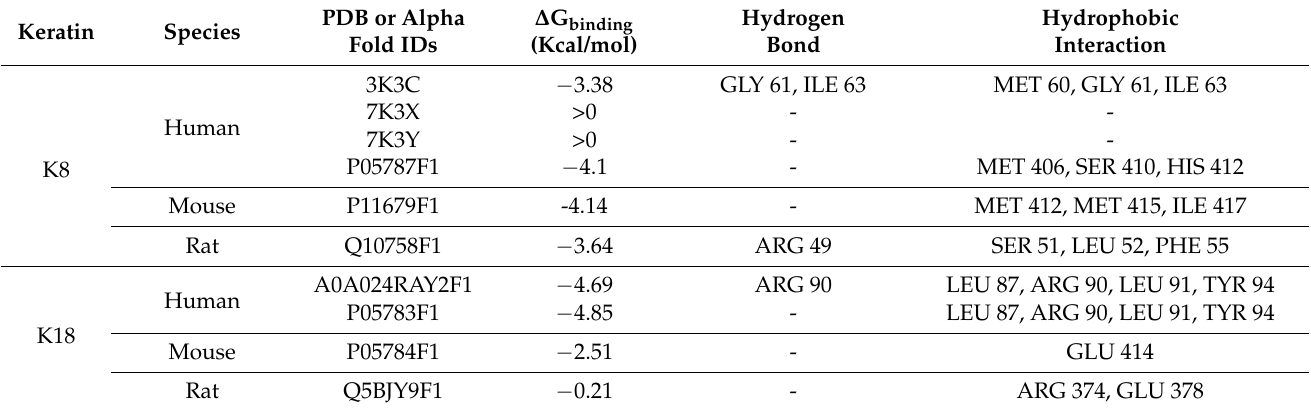
Table 2. Molecular docking details of Amiodarone interaction with Keratin 8 (K8), and Keratin 18 (K18) in Human, Rat, and